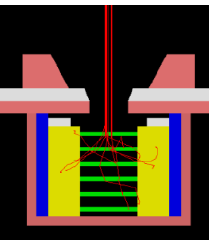
Figure 3. Schematic diagram of telescope system in the high-energy particle detector.